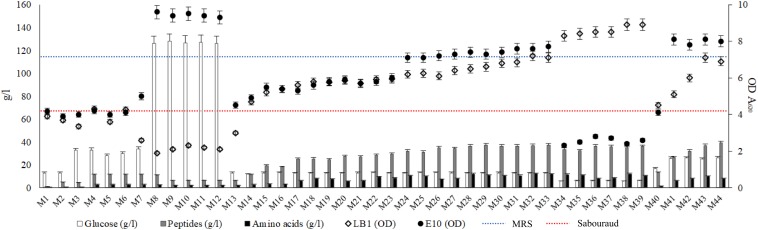
Concentration of glucose, peptides and amino acids (g/l) of the media obtained from wasted bread (Left axis). Dots represent the distribution of the optical density (A620 nm) values of Lactobacillus plantarum LB1 and Saccharomyces cerevisiae E10 after 24 h of incubation at 30°C in the experimental media (Right axis). Dotted lines indicate the growth of the same strains in reference media, MRS (blue) and Sabouraud (red) for LAB and yeasts, respectively. Experimental media (M1 to M44) correspondence is reported in Table 1.